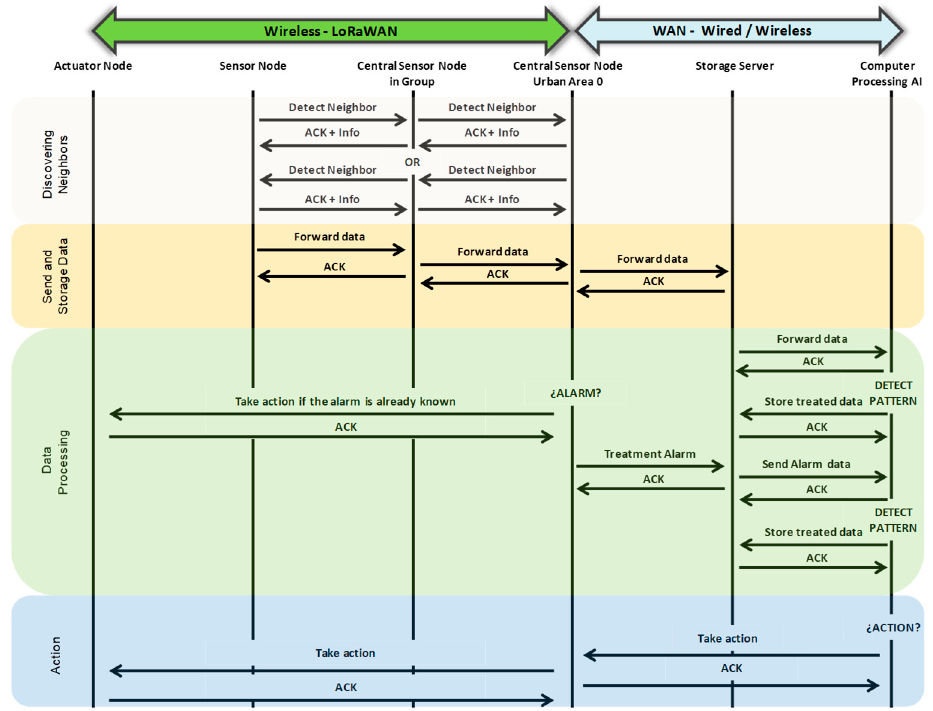
Figure 7. Proposed protocol.